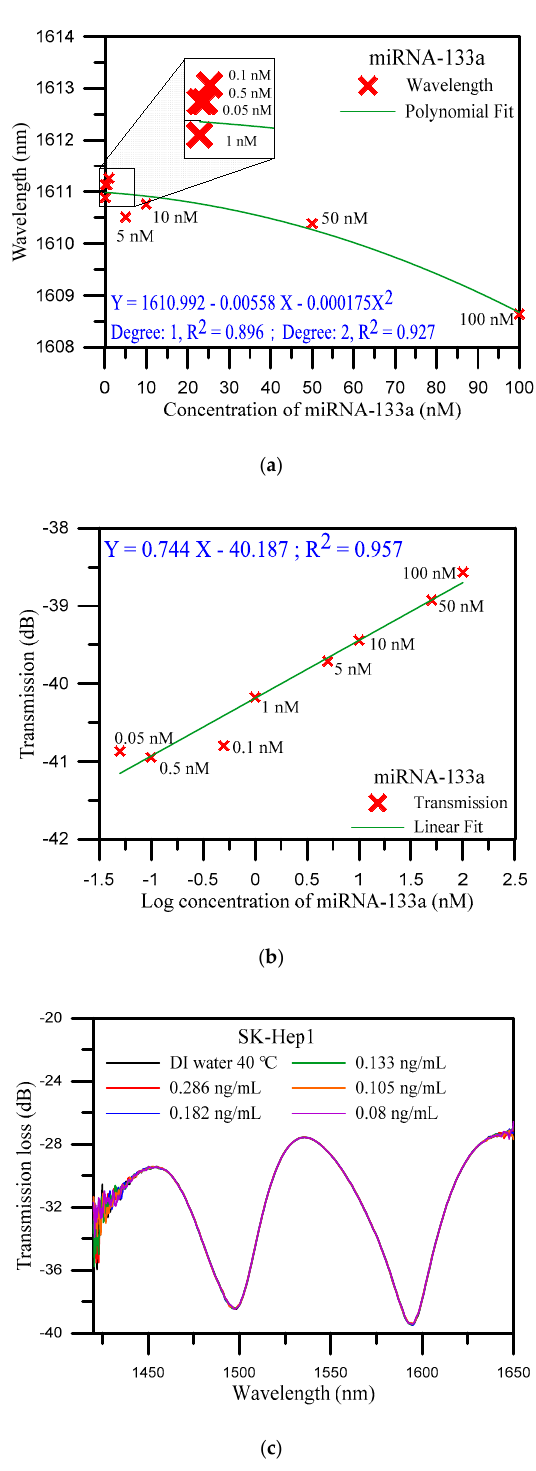
Figure 3. ( a ) Wavelength shift analysis diagram of standard miRNA-133a sample detection; ( b ) analysis diagram of transmission loss for standard miRNA-133a sample detection; and ( c ) spectrum diagrams of various concentrations of SK- Hep1 specimen solution.